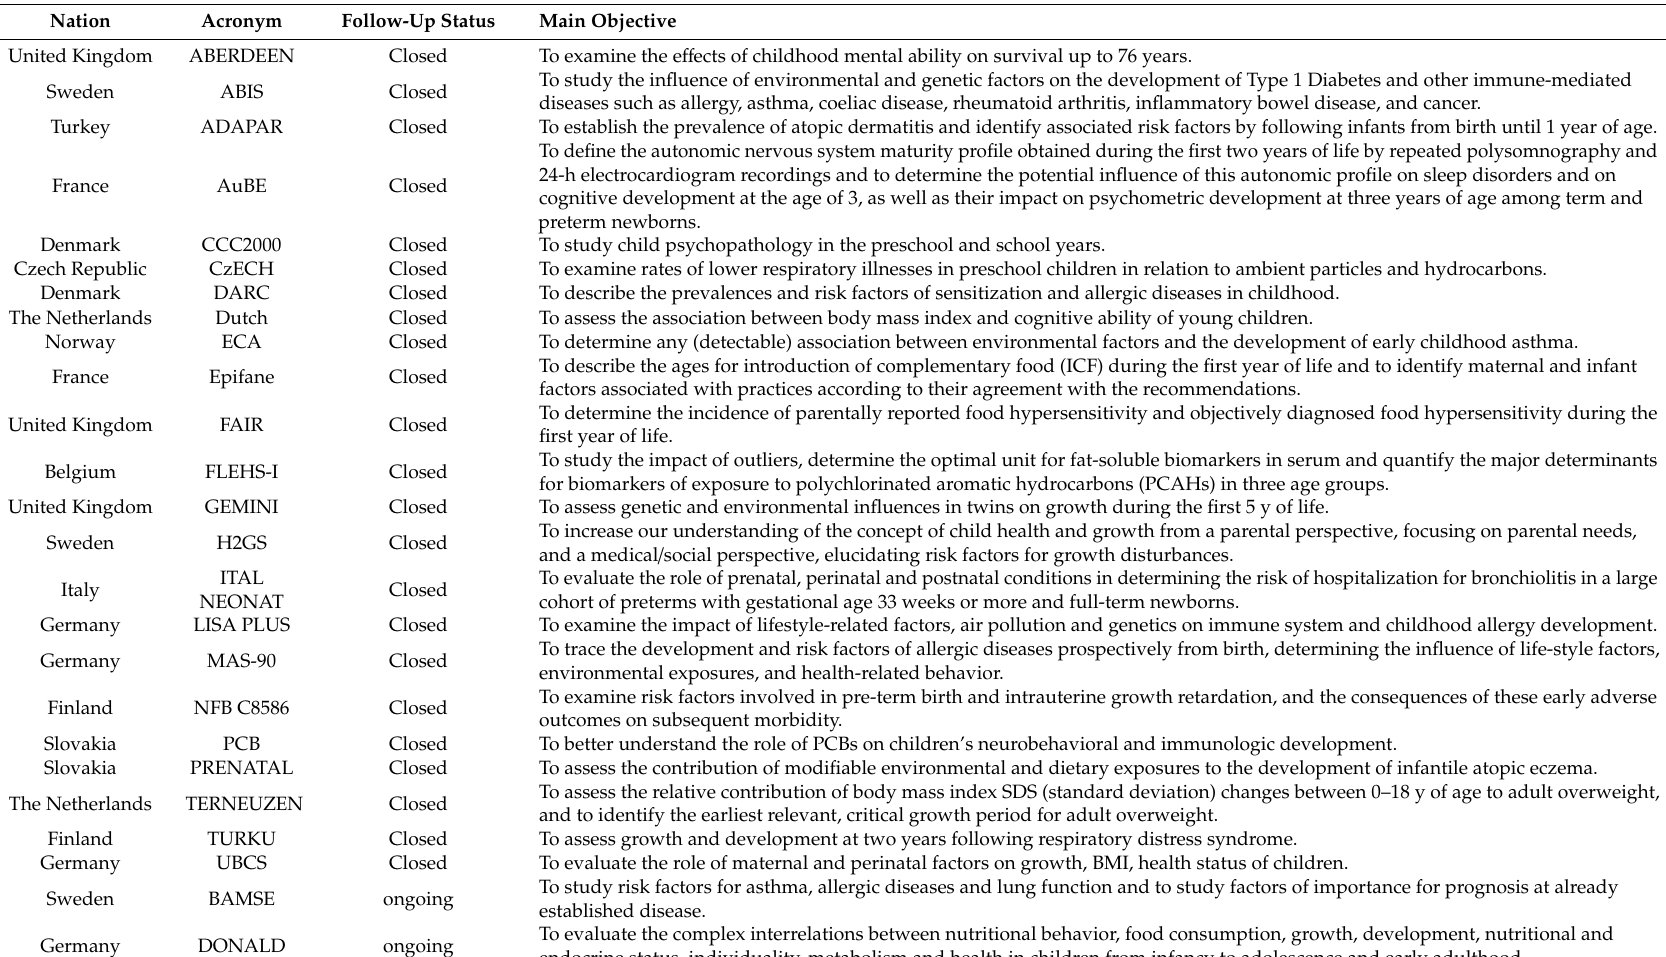
Table 2. Objectives of the 45